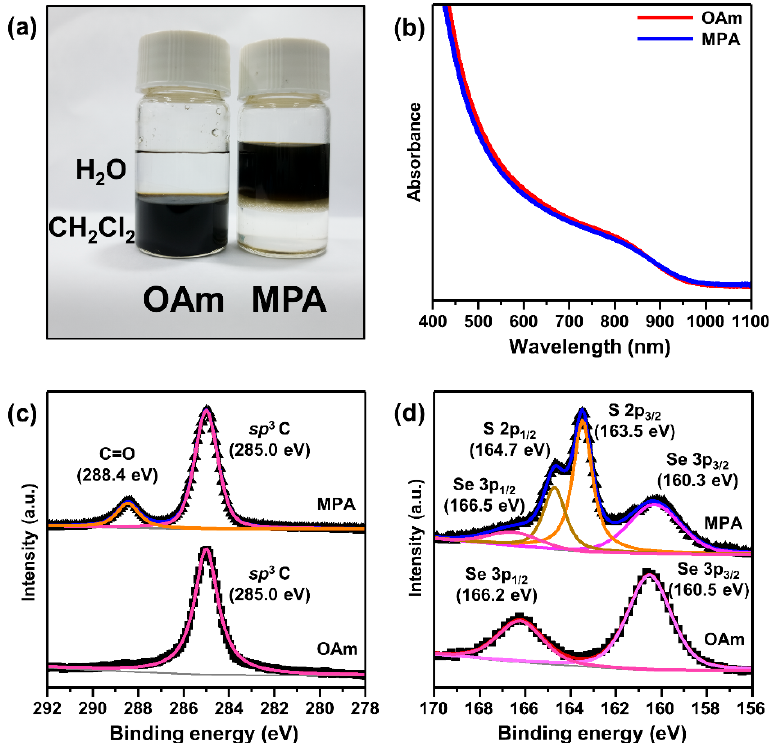
Figure 2. ( a ) Photograph of the two-phase ligand-exchange process. The bottom and top liquid layers are dichloromethane and water, respectively. OAm- and MPA-passivated QDs can be dispersed in dichloromethane and water, respectively. ( b ) Comparison of the absorption spectra of OAm- and MPA-passivated CISe QDs. XPS data for ( c ) C 1s and ( d ) S 2p, showing comparison between OAm- and MPA-passivated CISe QDs.